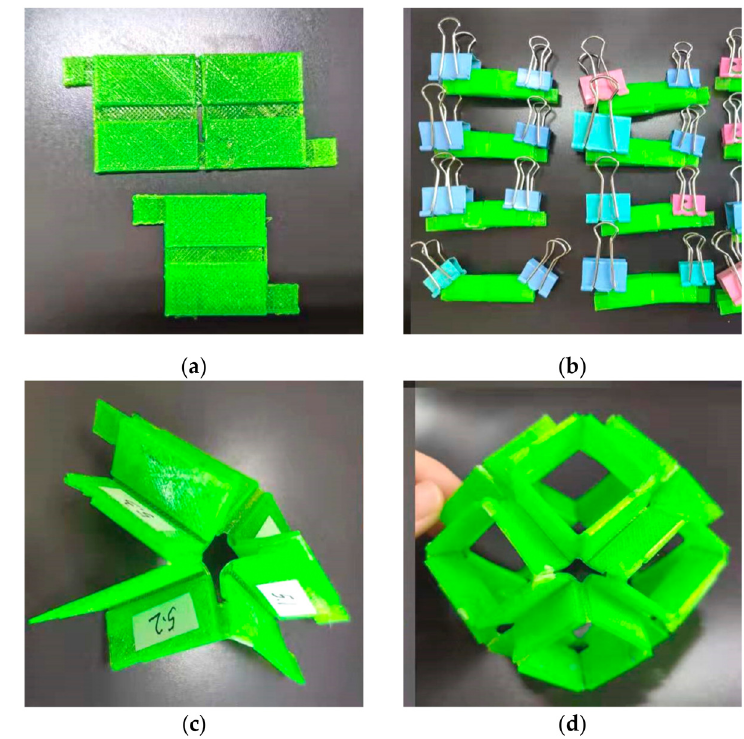
Figure 6. Fabrication of origami flexiball: ( a ) 3D printed thin sheet units; ( b ) bonding thin sheet units together; ( c ) a bonded module; ( d ) the finalized origami flexiball.